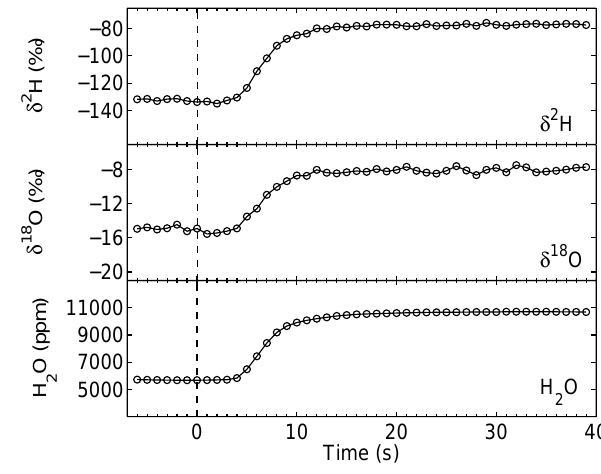
Fig. 3. Standard deviations of 1s measurements of δ 2 H (top) and δ 18 O (bottom) as a function of H 2 O mixing ratio. The dotted lines show 1/x-fits.